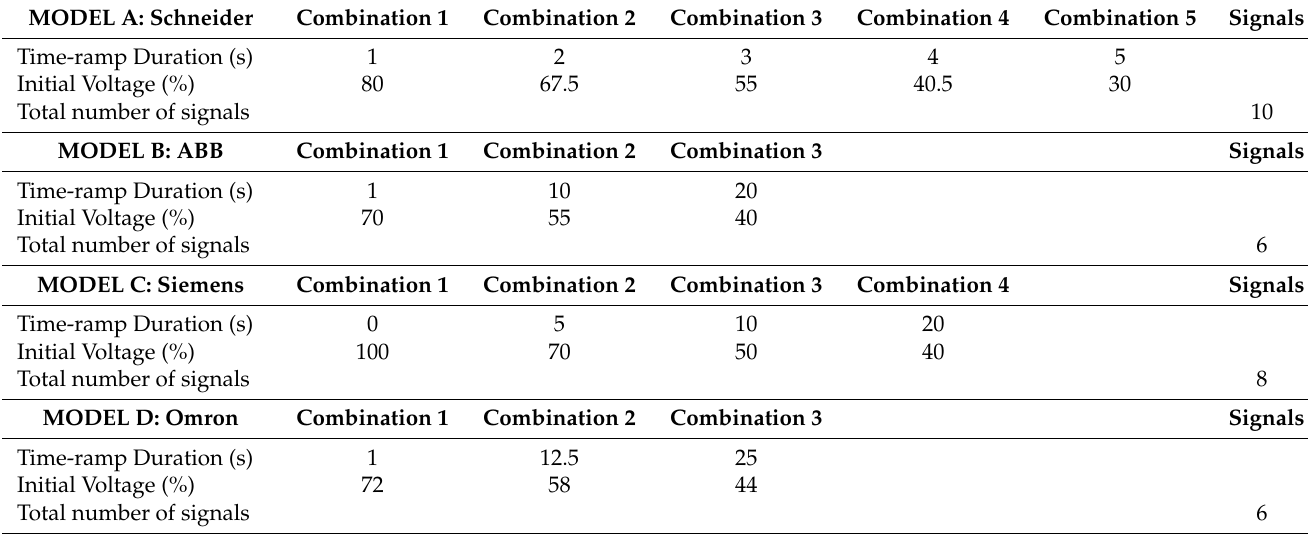
Table 8. Parameter combinations performed for each soft starter. Number of signals obtained.